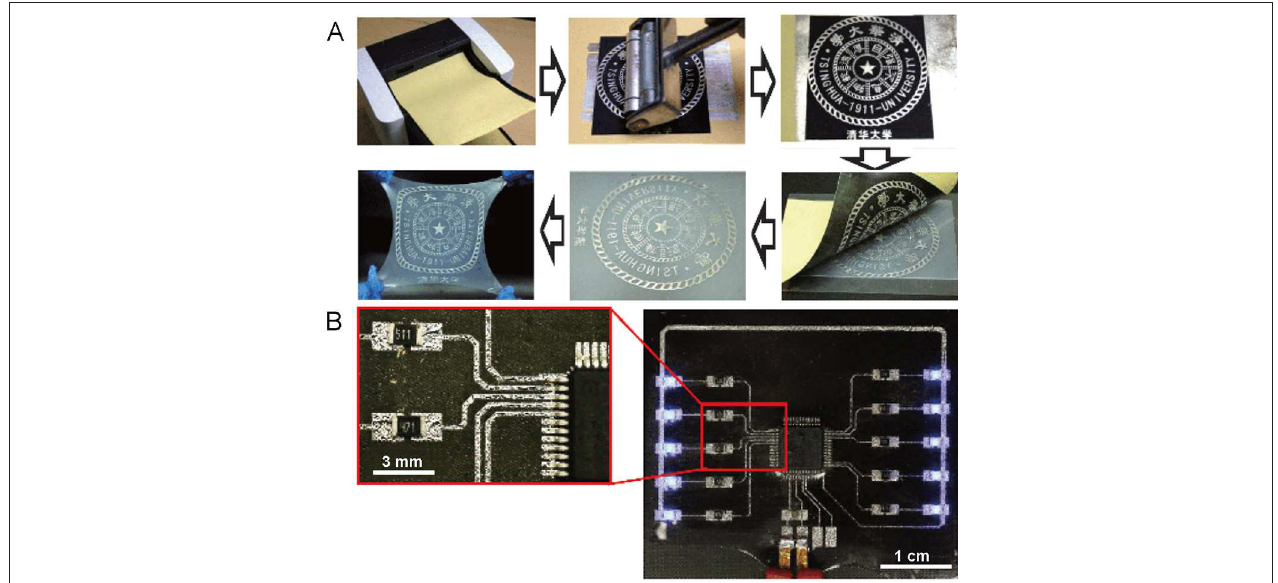
FIGURE 13 | The preparation process of liquid metal pattern with rolling and transfer printing method (A) , and a printed LED array flexible circuit on paper substrate (B) . Reproduced with permissions from Guo et al. (2019b). Copyright 2019, Science China Press and Springer Nature.